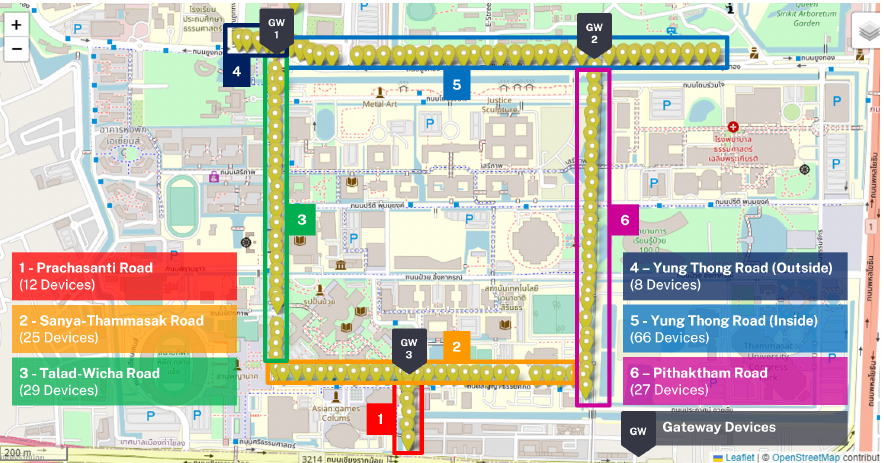
Figure 1. The map of Thammasat University, Rangsit Campus, Thailand, located at 14°04 (cid:48) 27 (cid:48)(cid:48) N, 100°36 (cid:48) 08 (cid:48)(cid:48) E. Yellow location markers display the locations of the 167 smart street lighting devices on the web application. Each color indicates the smart device management zone on the main roads of the campus. Gray markers notated with GW locate the installed location of three gateway